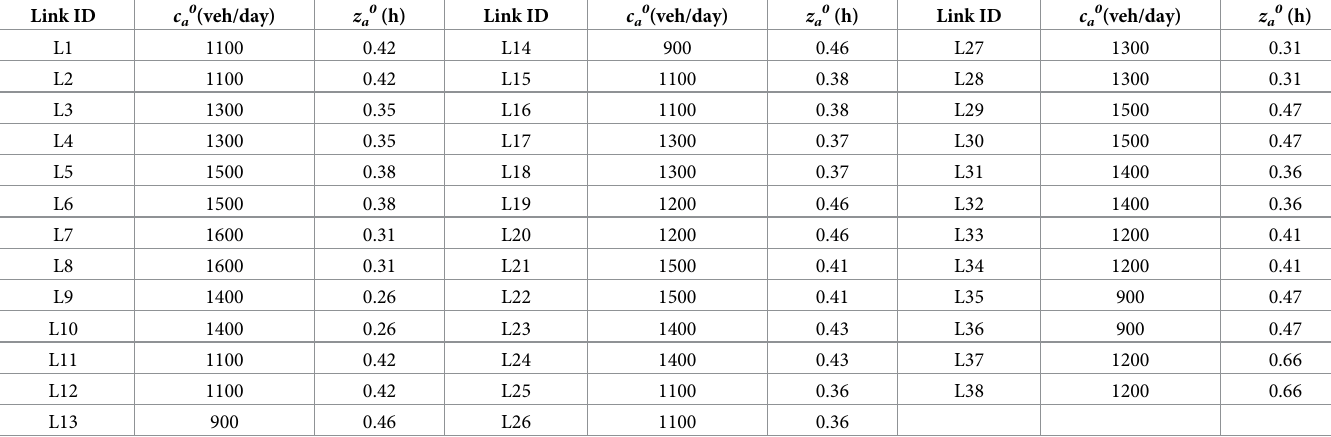
Table 2. Physical conditions of the 38